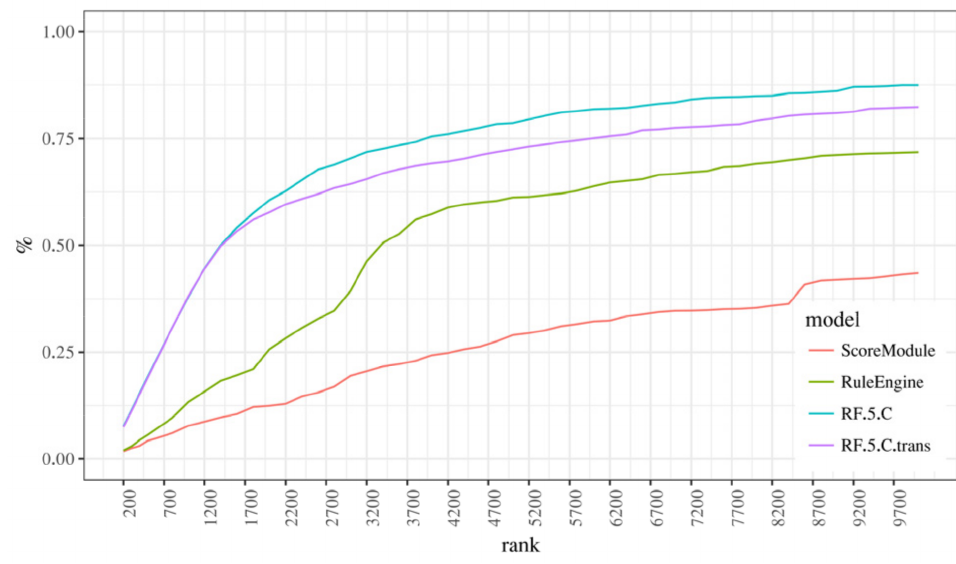
Figure 8. Ranked recall chart for the RF.5.C and baseline